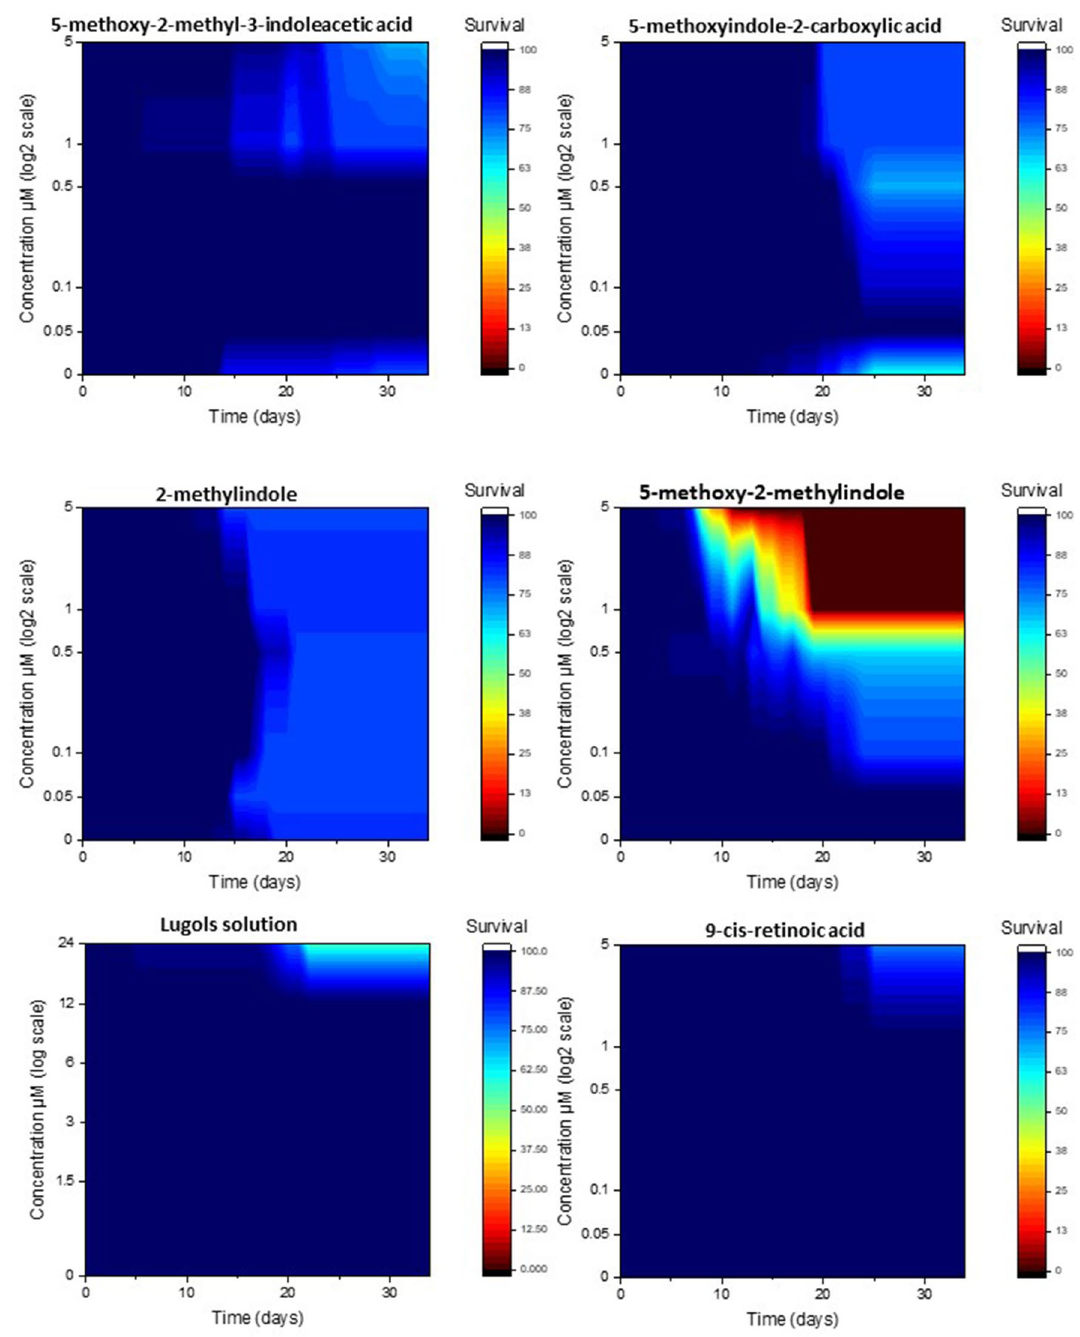
Figure 4. The cumulative percentage of Carukia barnesi polyps that survived (that did not morph) after exposure to six chemical treatments, over time in response to chemical